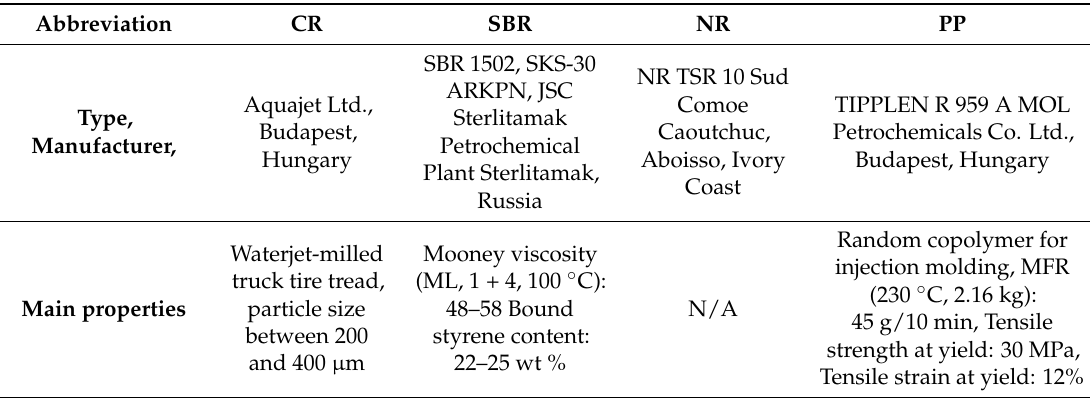
Table 1. Types and producers of raw